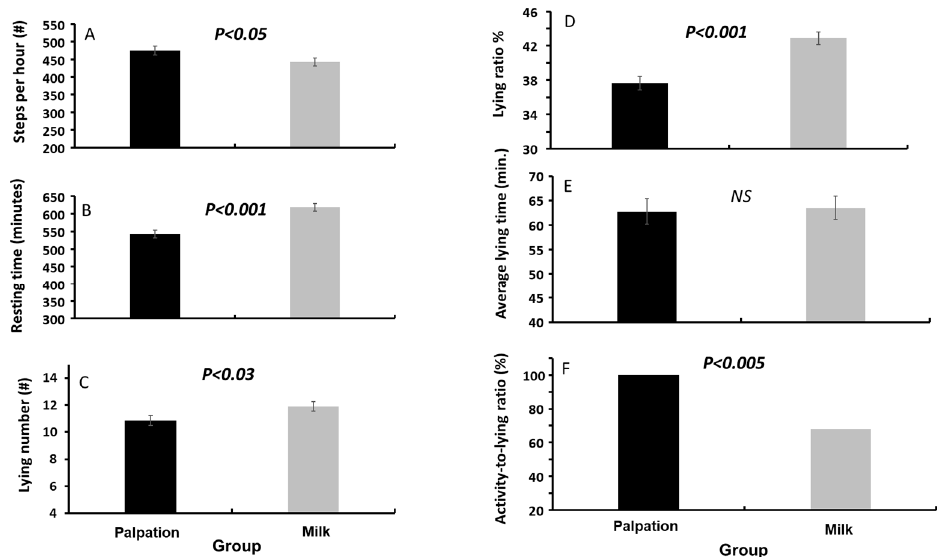
Figure 1. Pedometer data from dairy cows on day of rectal palpation vs. milk pregnancy test. ( A ) Number of steps per hour between two consecutive milking. ( B ) resting time in minute between two consecutive milking. ( C ). number of times the cow is lying between two consecutive milking. ( D ). percentage of lying between two consecutive milking. ( E ). average time for each lying event between two consecutive milking. ( F ). the ratio between activity time to lying time between two consecutive milking. NS—nun significant.